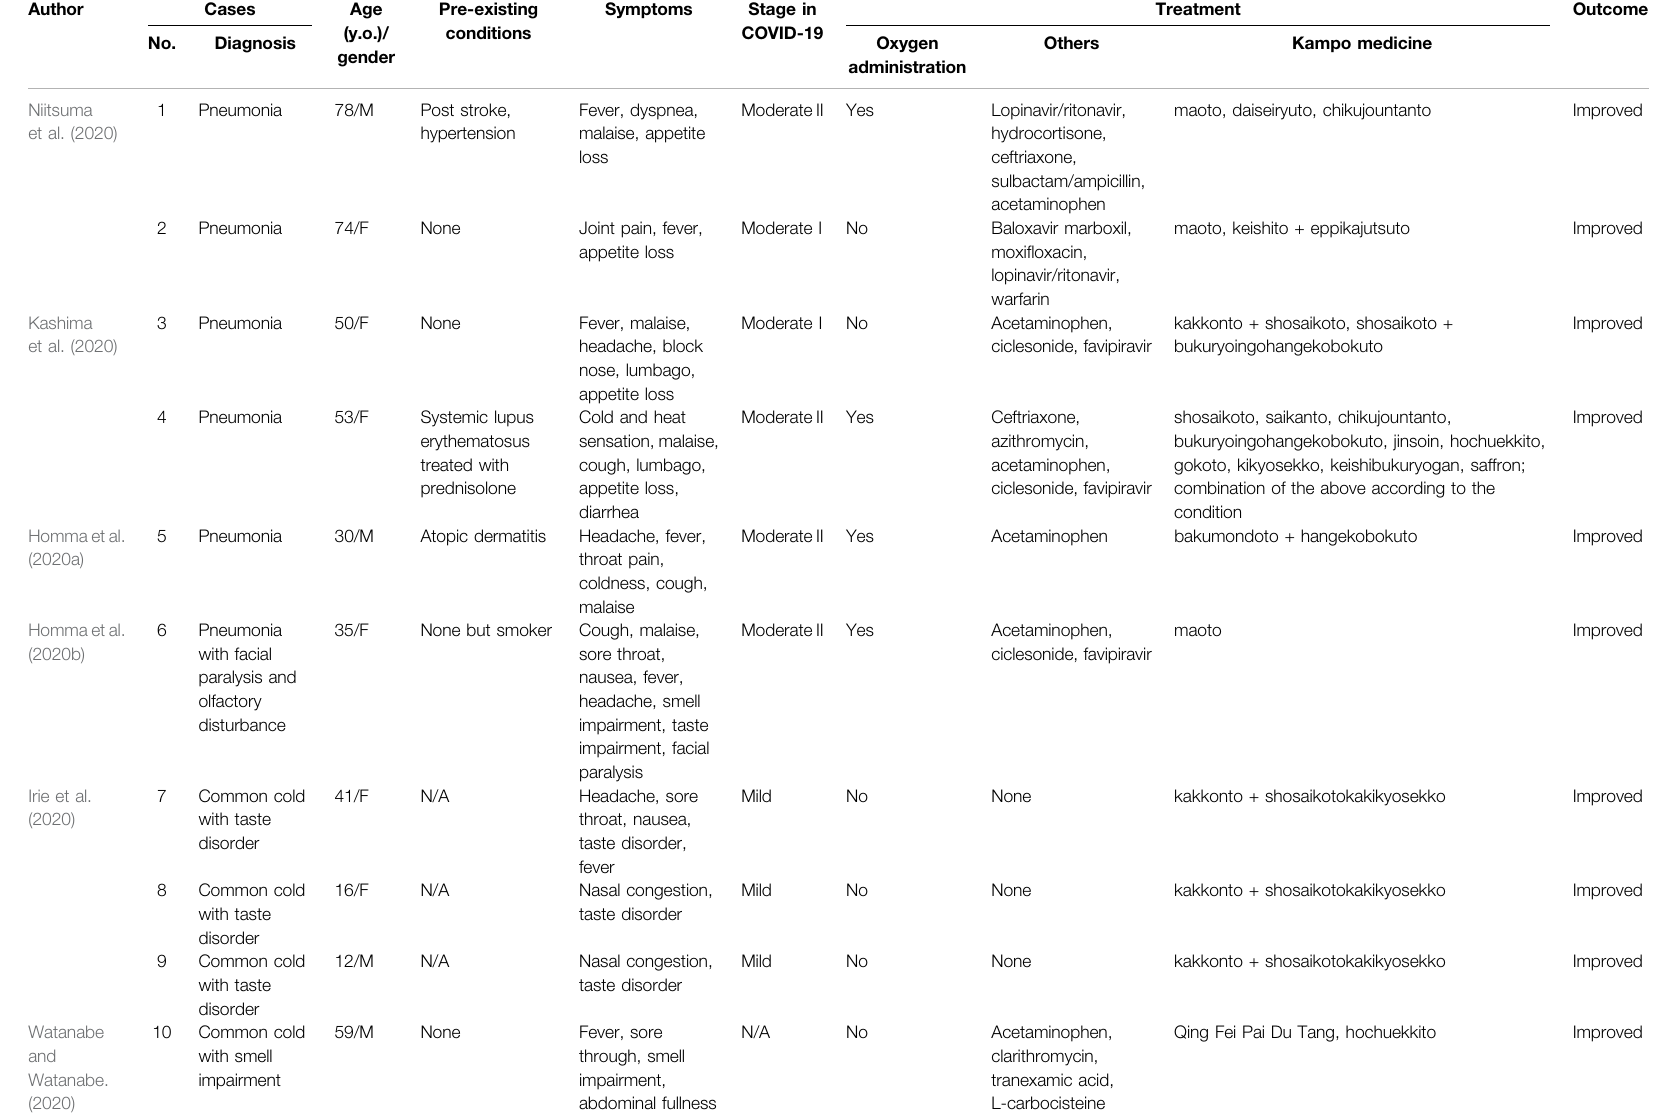
TABLE 1 | Review of clinical reports on the management of COVID-19 with Kampo